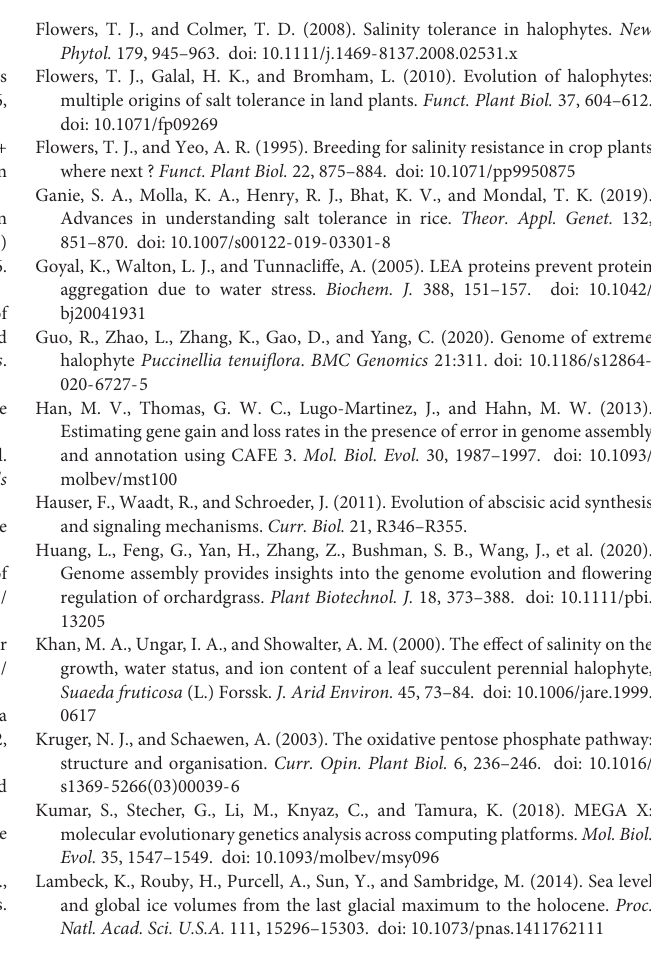
Supplementary Table 3 | List of P. tenuiflora genes that were positively selected during evolutionary history. Supplementary Table 4 | Differentially expressed genes in P. tenuiflora under salinity stress. The 15-day-old seedlings were exposed to 300 mM NaCl for 12 and 48 h. Each treatment had three biological replicates. Supplementary Table 5 | Differentially expressed salinity-tolerant genes in P. tenuiflora under salinity stress. The 15-day-old seedlings were exposed to 300 mM NaCl for 12 and 48 h. Each treatment had three biological replicates. Supplementary Table 6 | Comparative fold changes (stress/control) of qRT-PCR and RNA-seq in P. tenuiflora roots at 48 h. Each treatment had three biological replicates, and each biological replicate comprised a pool of 10 plants. The gene-specific primers were displayed. Supplementary Table 7 | Number of HKT , AKT , and NHX families in P. tenuiflora , rice, D. glomerata , and Arabidopsis